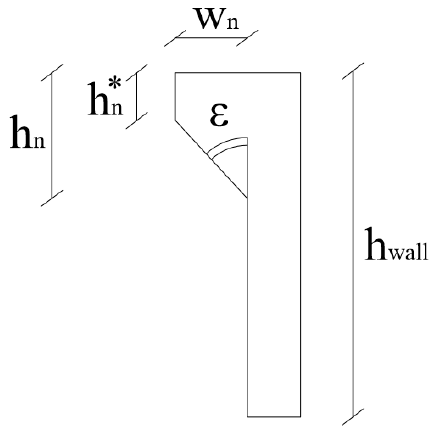
Figure 10. The scheme of a parapet with all the geometrical parameters.